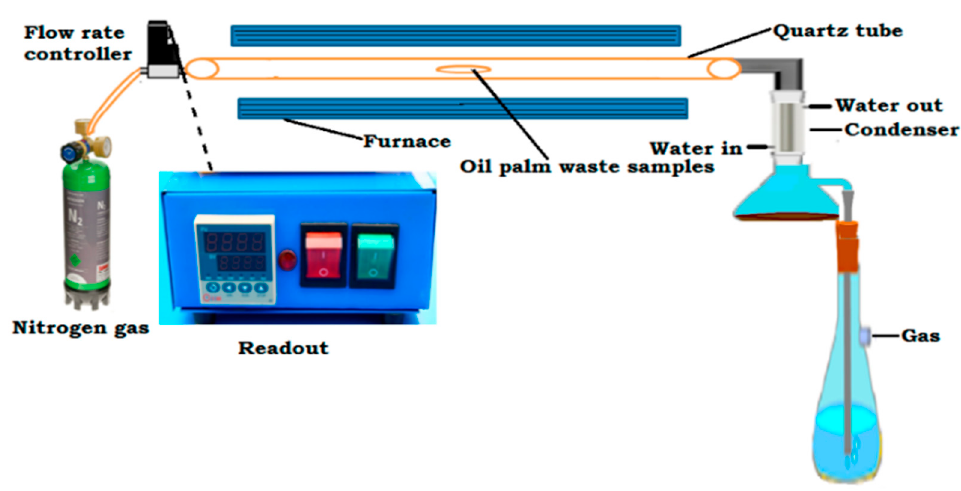
Figure 2. Furnace for the process of carbonization of PKS to CPKS [57].